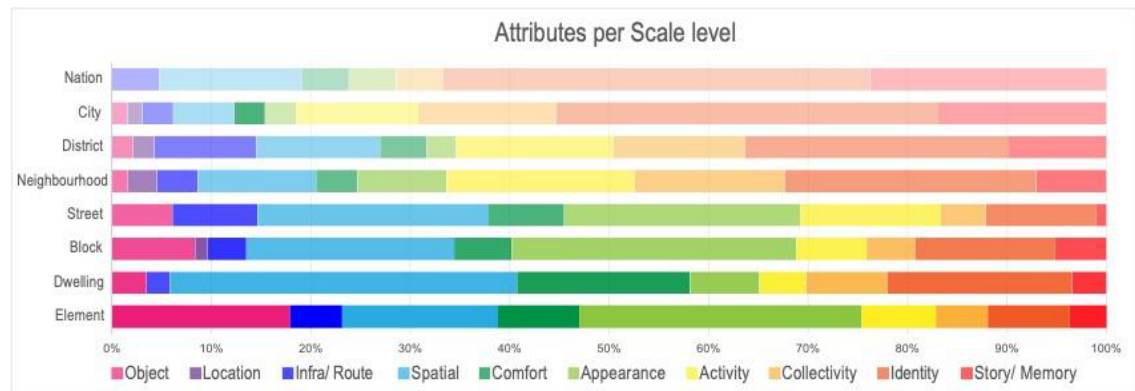
Figure 4. Attribute categories grouped by scale (total sample). The bars show the percentage of quotations on the relation attribute-scale.